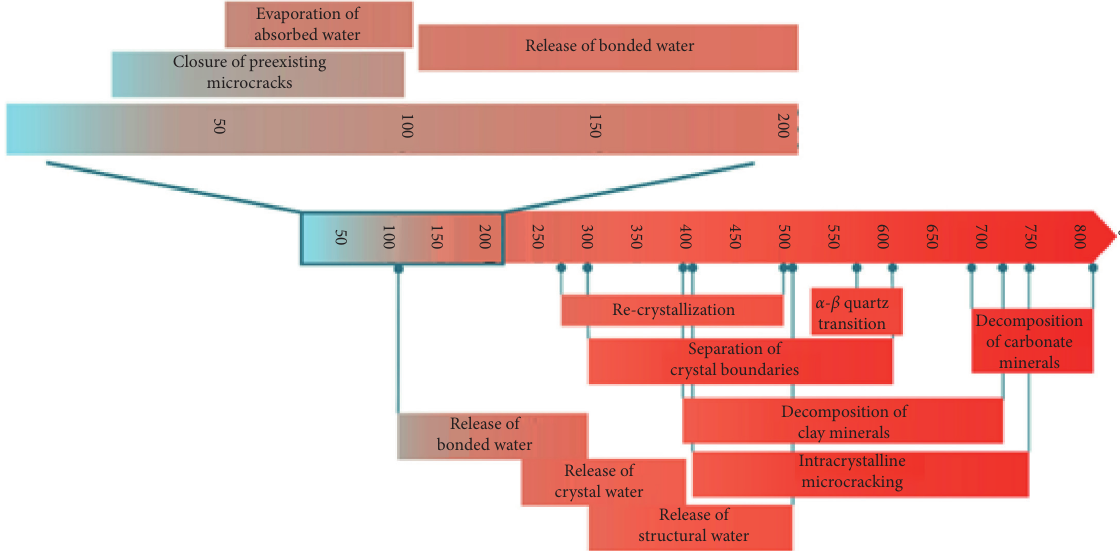
Figure 2: Variations of internal composition and structure of rocks at different temperatures